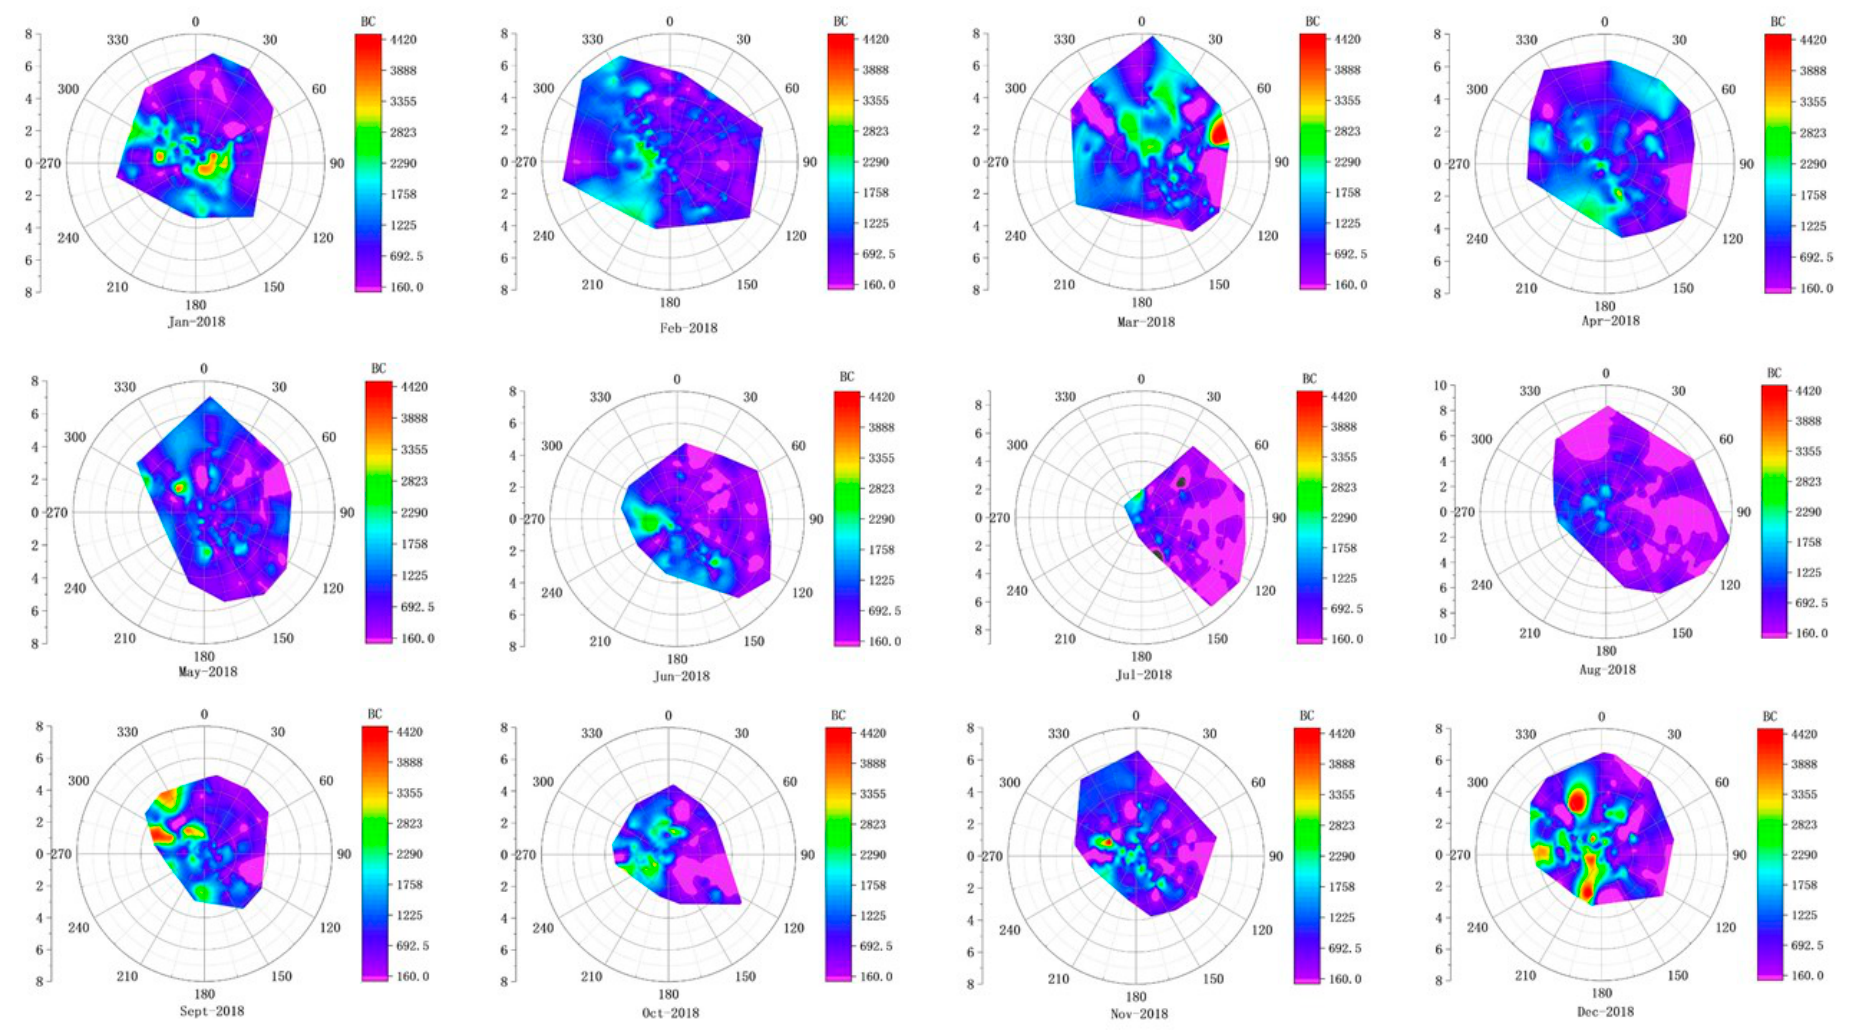
Figure 3. Seasonal variation in BC under different weather conditions in 2018.